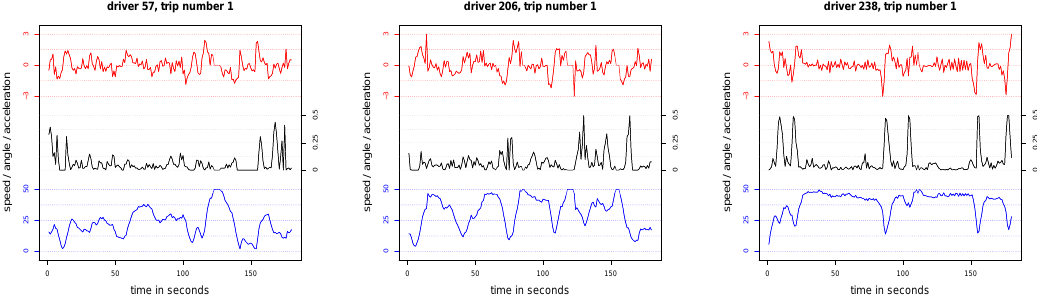
Figure 1. First trips of drivers 57 ( left ), 206 ( middle ) and 238 ( right ): the lower line in blue color shows the speeds ( v t ) t (in km/h), the upper line in red color shows that acceleration/braking ( a t ) t (in m/s 2 ), and the middle line in black color shows the changes in angle ( ∆ t ) t .